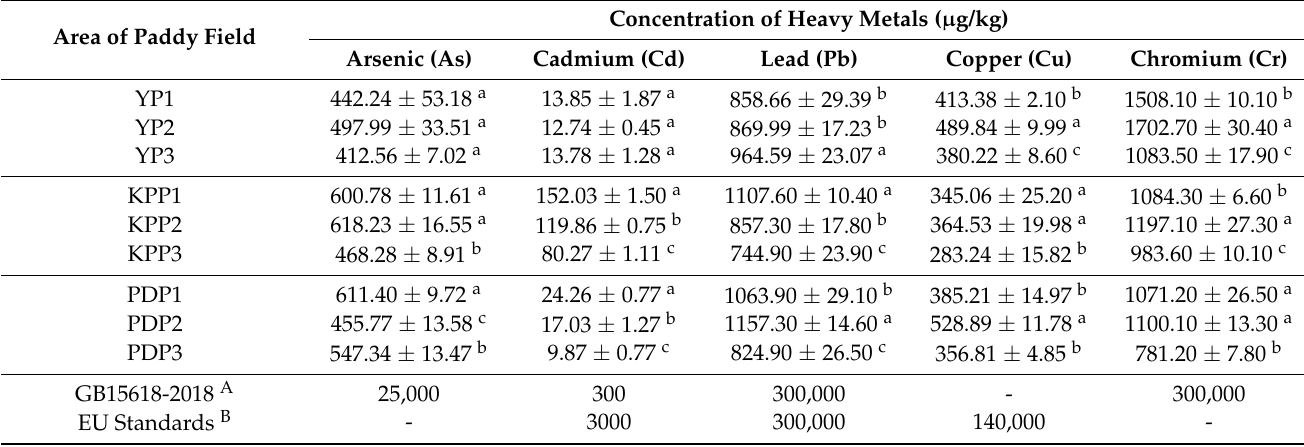
Table 1. Concentration of heavy metals in paddy soils from the Kedah area.